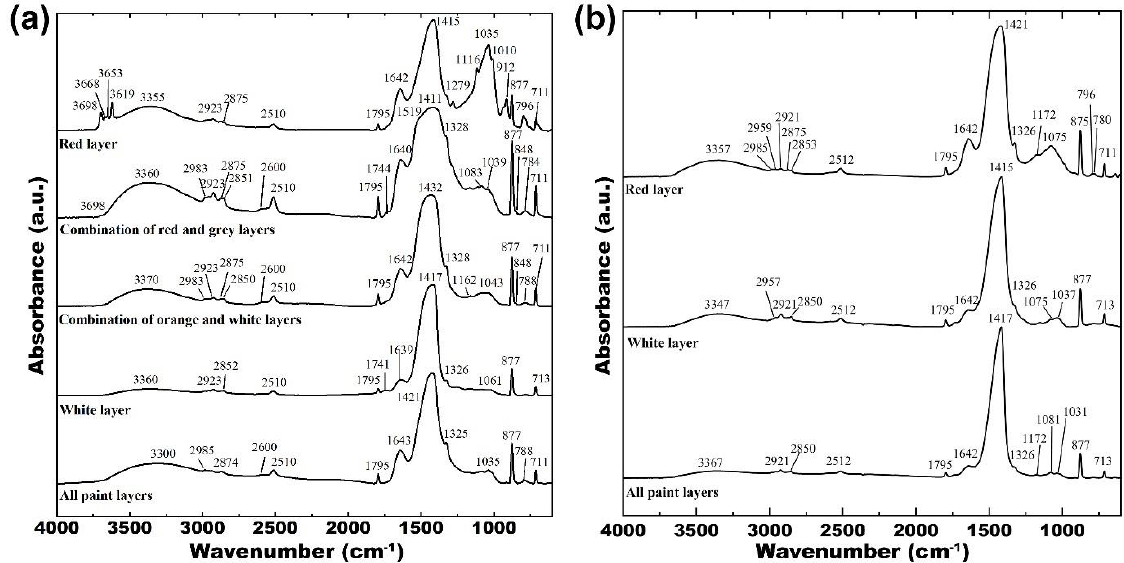
Figure 5. Fourier-Transform Infrared (FT-IR) spectra in the region 4000–600 cm −1 for ( a ) H1a and ( b ) E1a with layer isolation. Optical images of both cross sections can be found in supplementary information. See supplementary information for spectral interpretation of historic paint samples.